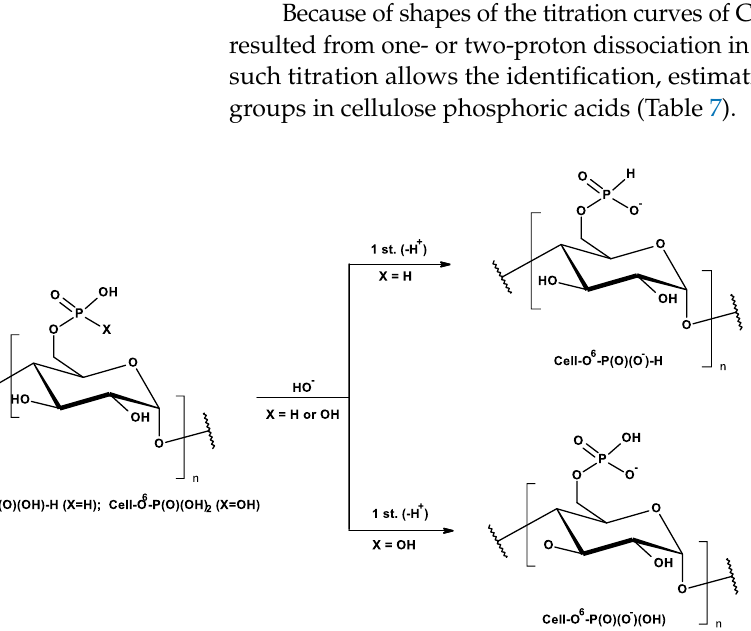
a/ Assignment according to Ibrahim et al. [69]. α - D -Glucose — Gluc-OH; Gluc- O 6 -P(O)(OH) 2 — Glucose- O 6 -phosphate. Vibra- tions derived from phosphoric(III/V) functions are marked in red.